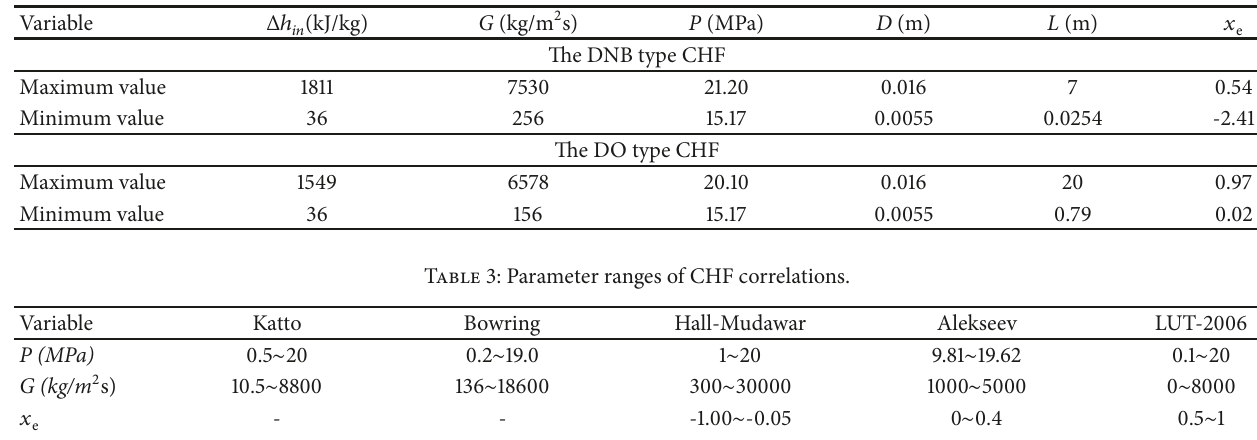
Table 2: Experimental ranges of database.